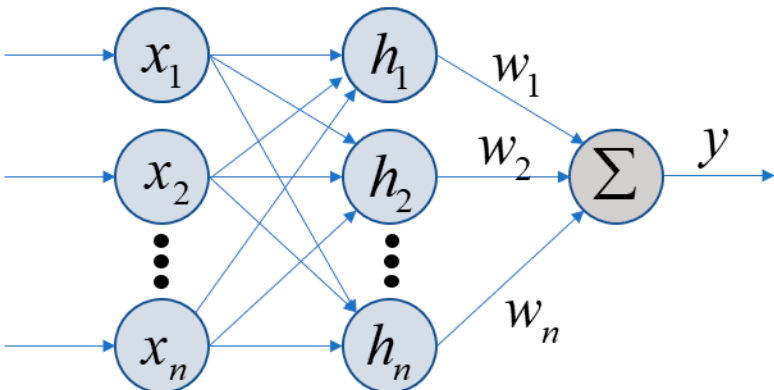
Figure 2. Principle of RBF neural network.